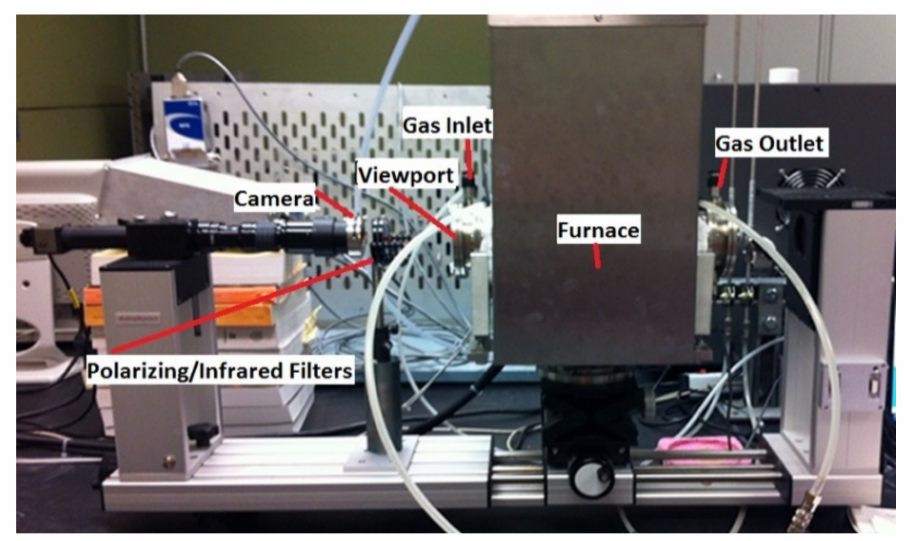
Figure 2. Tensiometer